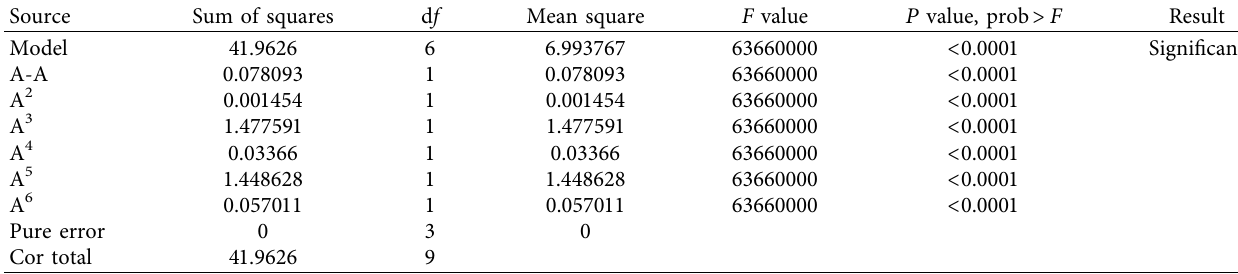
Table 8: ANOVA analysis of rice bran.